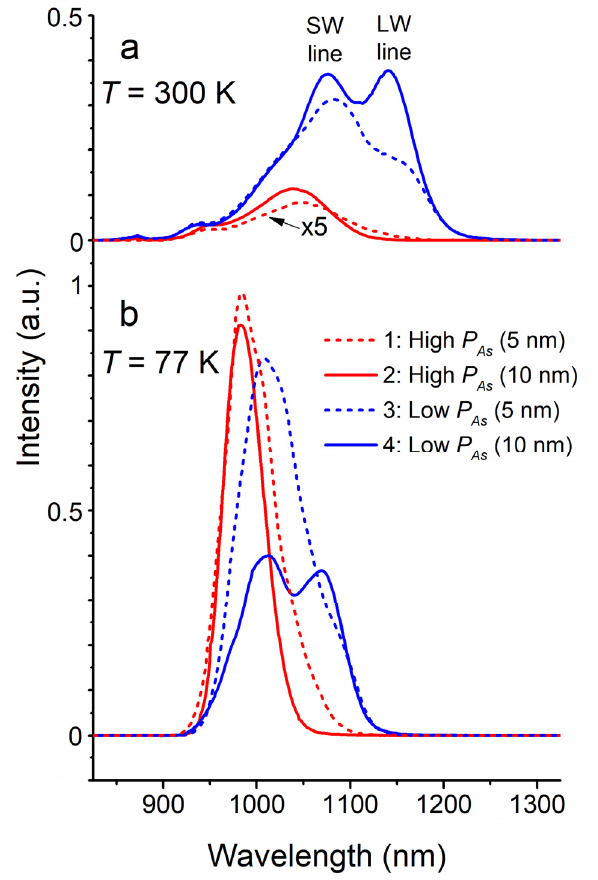
Figure 3. 300 K ( a ) and 77 K ( b ) PL spectra of structures with InAs QDs overgrown by the GaAs layer under various growth conditions according to the sample numbers in the legend: red lines: P As = 3 × 10 − 5 Pa; blue lines: P As = 1 × 10 − 5 Pa; solid lines: 10 nm; dashed lines: 5 nm. When QDs are overgrown at P As = 3 × 10 − 5 Pa, an unambiguous single broad line is observed in the room-temperature PL spectrum at 1049 and 1038 nm (shortwave (SW) line) for the LT-GaAs thicknesses of 5 and 10 nm, respectively (Figure 3a), whereas at P As = 1 × 10 − 5 Pa, two longer wave lines are pronounced. The first line (SW) is approximately the same for both LT-GaAs thicknesses and shifted to ~1080 nm. The longwave (LW) line is at a wavelength of ~1160 and ~1140 nm for 5 and 10 nm LT-GaAs, respectively. Alt- hough the appearance of an additional LW line is often attributed to an array of coalesced QDs [11], we consider that its contribution is not sufficient to give a pronounced PL peak, taking into account the two-orders-of-magnitude-lower surface density of coalesced QDs compared with basic ones. Moreover, the coalescence of QDs before capping is equally inherent in each of the PL structures under consideration, but the additional LW lines appear only after the overgrowth at P As = 1 × 10 − 5 Pa. Therefore, this behavior is not due to